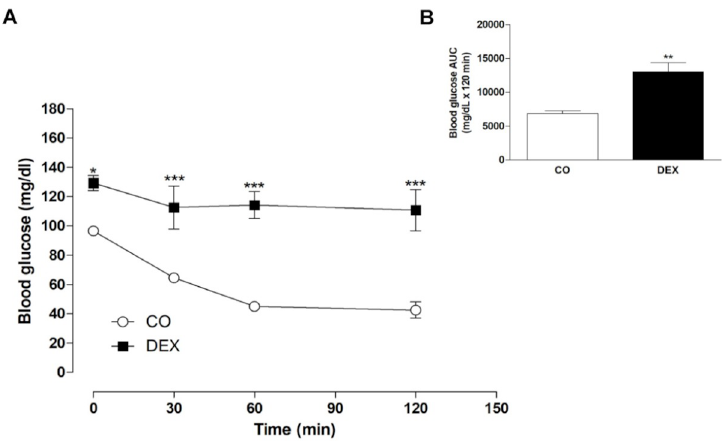
Fig 1. (A) Insulin tolerance test (ITT) and (B) area under the curve (AUC) data for blood glucose. Values are expressed as mean ± S.E.M. For data analysis, one-way ANOVA followed by Bonferroni post-test was used for the ITT, and Student’s unpaired t-test was used for the AUC. � p < 0.05, �� p < 0.01, ��� p < 0.001, CO vs